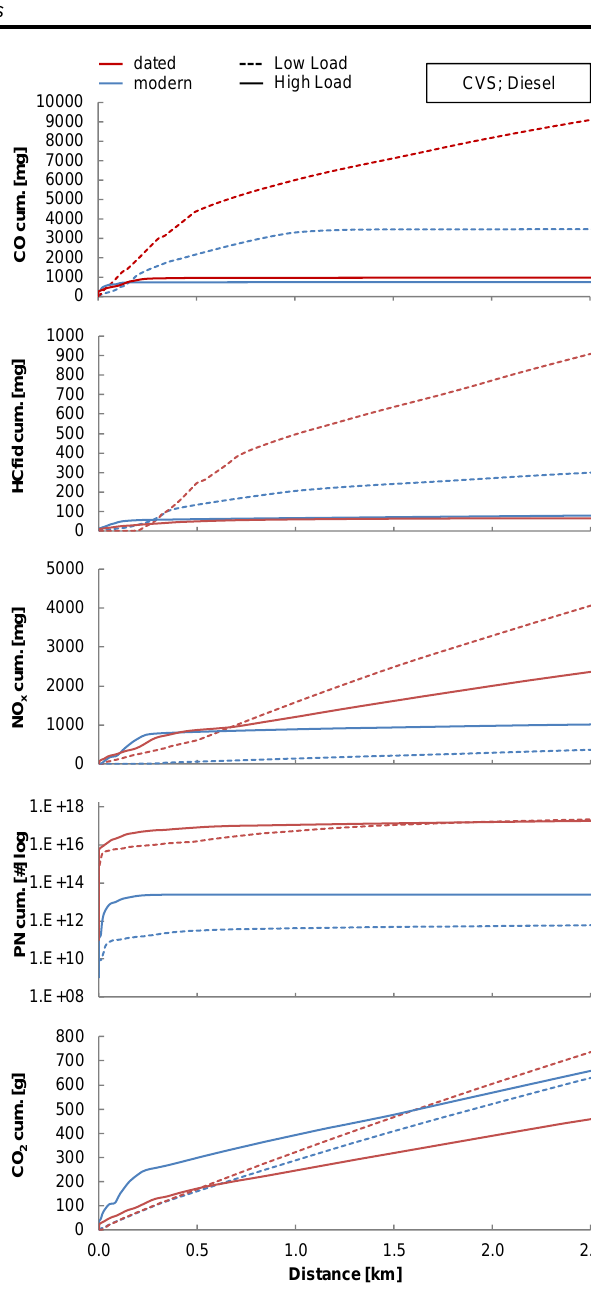
Fig. 14. Cumulated emissions during warm-up on chassis dynamometer with two Diesel vehicles and different